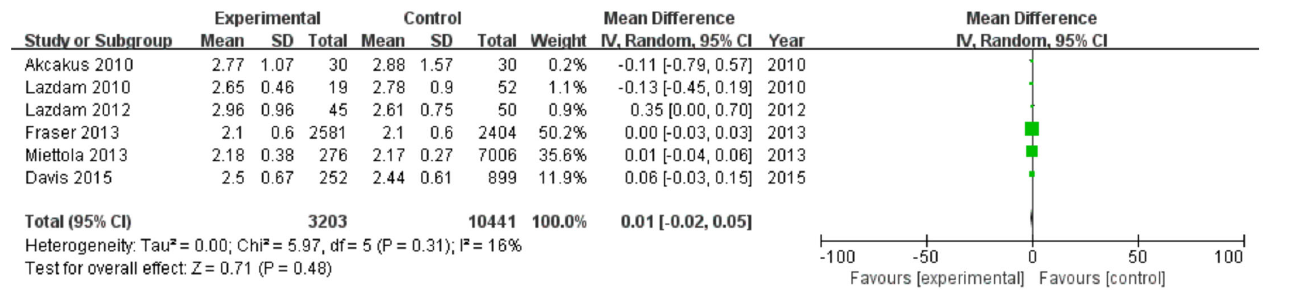
Figure 5. Meta-analysis forest map for systolic blood pressure of offspring of PE Figure 5. Meta ‐ analysis forest map for low ‐ density lipoprotein cholesterol of offspring of PE preg ‐